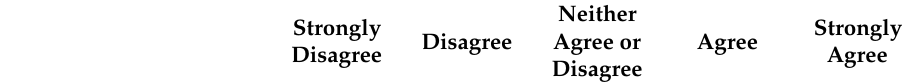
Table A1. The Psychosocial Safety Climate (PSC-12)